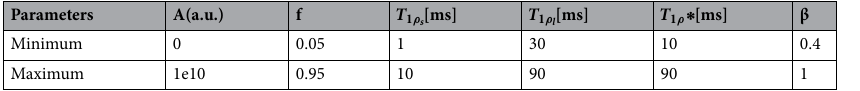
Table 1. Minimum and maximum values were considered for each of the models’ parameters. The estimated values are constrained to improve estimation stability.